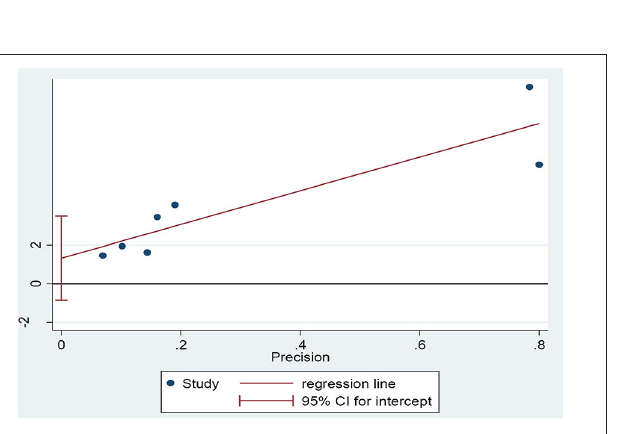
FIGURE 3 | Publication bias based on Egger‘s